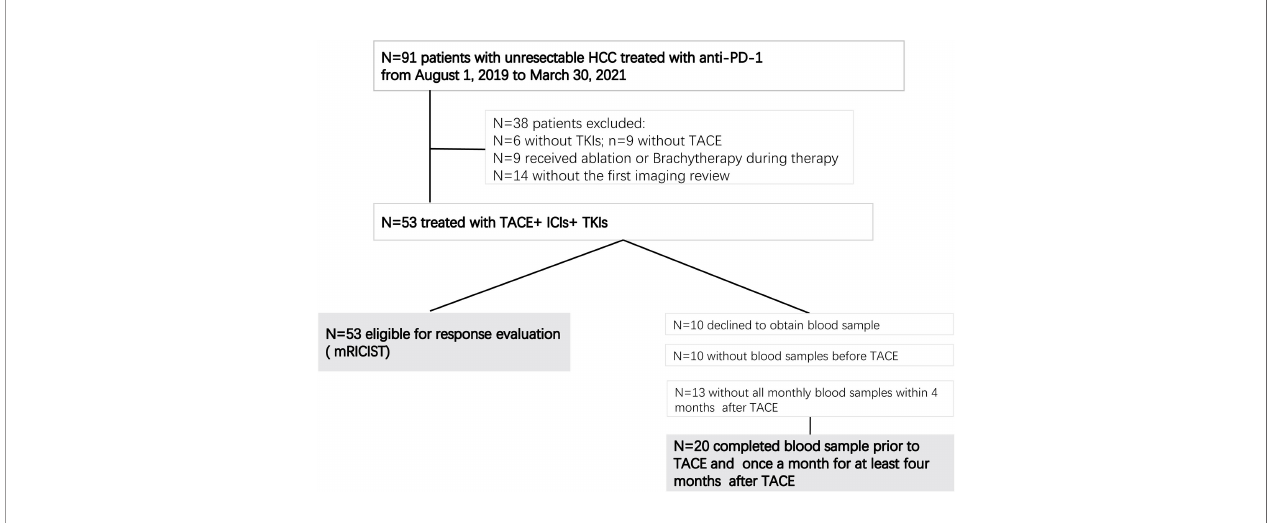
FIGURE 1 | Patient fl ow chart.